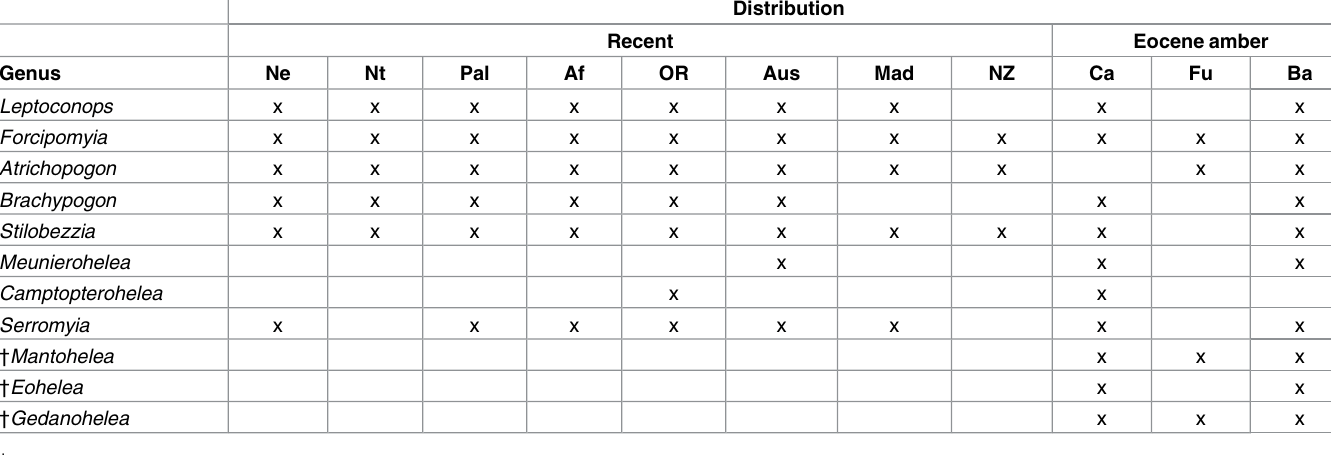
Table 3. Distribution of select extant and fossil Ceratopogonidae genera (data after [25]). Abbreviations: Ne: Nearctic Region;Nt: NeotropicRegion; Pal: PalaearcticRegion; Af: AfrotropicalRegion;OR: Oriental Region;Aus: Australia; Mad: Madagascar; NZ: New Zealand; Ca: Cambayamber; Fu: Fushun amber; Ba: Baltic